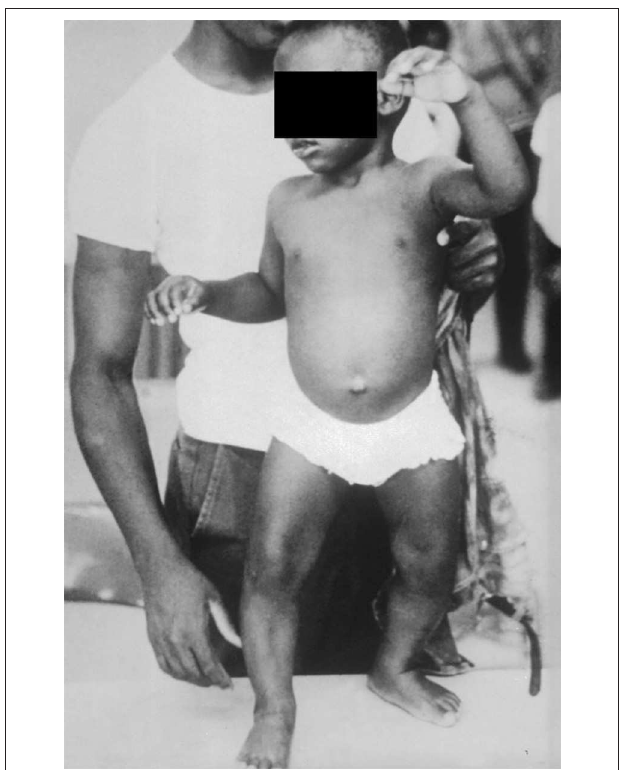
FIGURE 2 | Child suffering from vitamin D deficiency rickets in 1970—image obtained from the Center for Disease Control via the Public Health Image Library (PHIL) at https://phil.cdc.gov/phil/details.asp (open access).